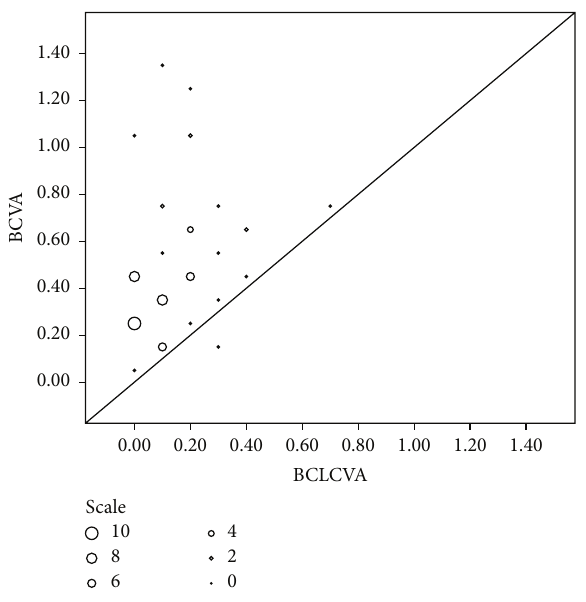
Figure 2: BCLCVA versus BCVA (logMAR).